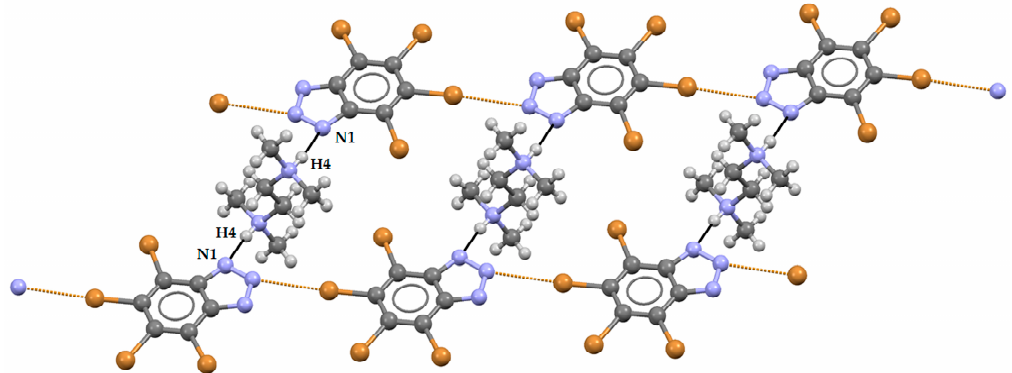
Figure 2. Three bis-protonated TMEDA molecules and hydrogen-bonded TBBT units (Mercury 3.9, ball and stick representation). HBs are represented by black lines; Br ··· N halogen bonds are represented by brown dotted lines. The color code of atoms is the same as that in Figure 1.